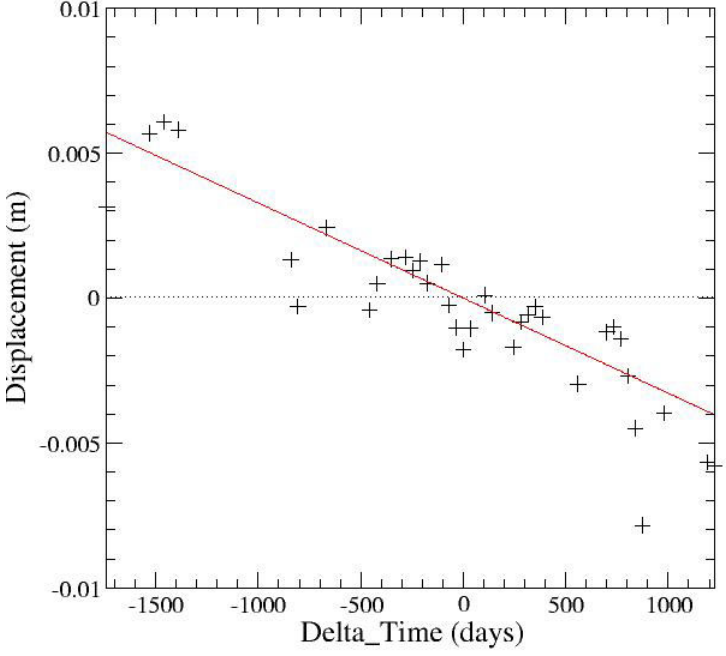
Figure 11. Displacement history obtained by IPTA for specific point target from the northern part of the